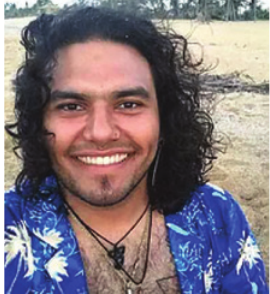
Figure 9 Julian Garay-Vazquez (Source: photograph by Julian